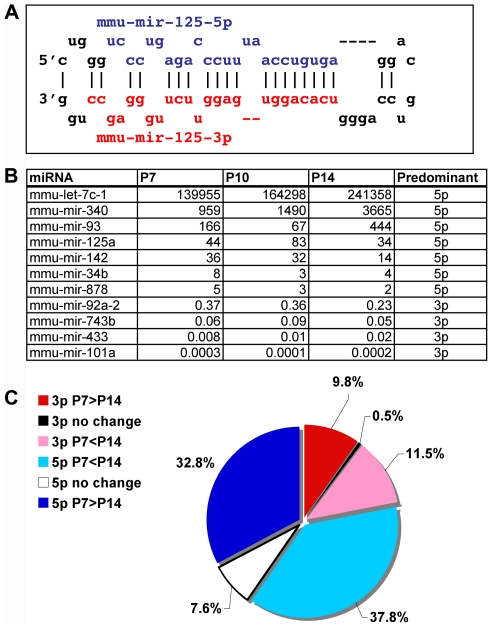
Mature miRNAs and star strands are differentially expressed in the testis.(A) Example miRNA identifying the 5p (red) and 3p (blue) miRNAs that will result from Dicer cleavage of the mmu-mir-125a pre-miRNA hairpin. Levels of 5p and 3p often are dramatically different in abundance in non-reproductive tissues, producing a 5p/3p ratio different from 1. (B) Shown are representative miRNAs in which reads were detected for both mature 5p and 3p sequences. Contrary to one report arguing for equivalent levels of both strands in the testis, we found that the pubertal testis was similar to other non-reproductive tissues. 73–87% of miRNAs displayed a 5p/3p ratio <0.5 or >2 (range 0.0001–240,000), consistent with differential stability of most 5p/3p miRNA pairs. (C) Most miRNAs showed predominant expression of either 5p or 3p reads. In 87% of miRNAs the 5p miRNA was more abundant compared to 3p (13%). Among the 5p miRNAs roughly one third were enriched at P7 (blue), P14 (teal), or unchanged (gray). Equal amounts of the 3p miRNAs were enriched at P7 (red) and P14 (pink).